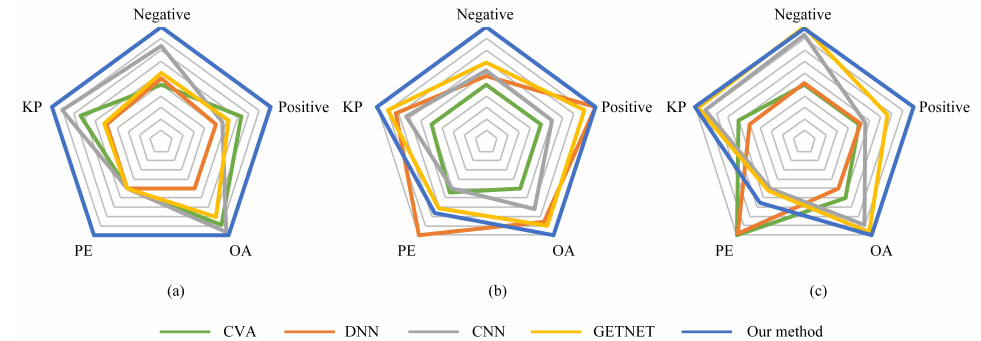
Figure 12. Metrics comparison of different algorithms on the three datasets. ( a ) Metrics comparison of the Hermiston City Area dataset. ( b ) Metrics comparison on the Bay Area dataset. ( c ) Metrics comparison of the Santa Barbara